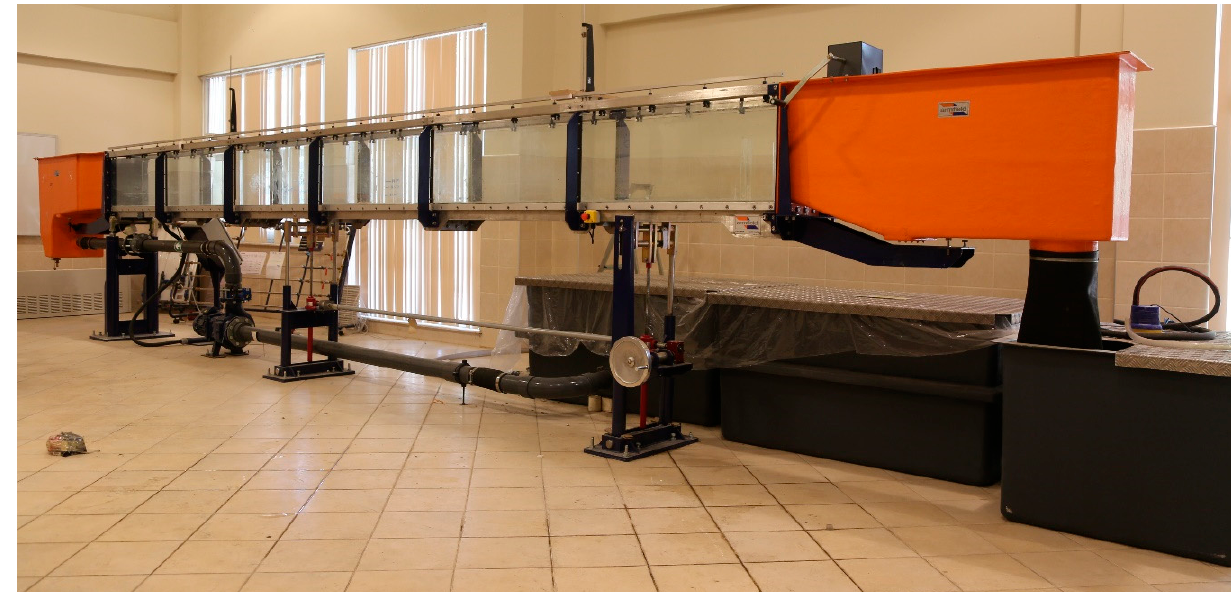
Figure 2. Arm fi eld S6 − MKII laboratory fl ow channel. Figure 2. Armfield S6 − MKII laboratory flow channel.